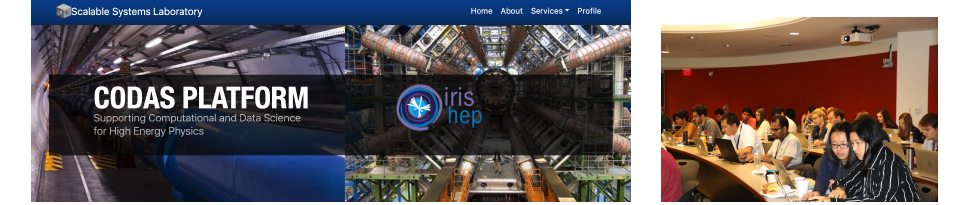
Figure 5: Left: the web portal to a (notebook interface) machine learning platform which has been used for the Computational and Data Science for High Energy Physics (CoDaS-HEP) summer course at Princeton University, pictured at right.